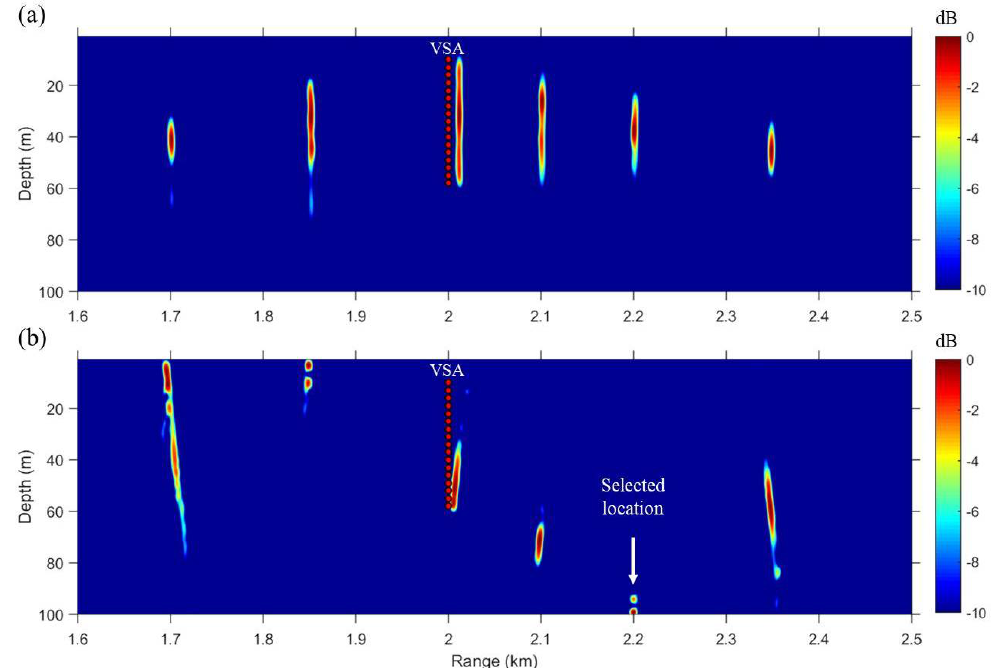
Figure 1. (Color online) Schematic of virtual source array (VSA)-based time reversal (TR) focusing and waveguide conditions used for numerical simulations. ( a ) Different vertical arrays, denoted by time-reversal mirror (TRM) (blue circle) and VSA (red circle), of 27 and 17 elements with 3-m array spacing are considered in 100-m deep shallow water; ( b ) Sound speed profile used for normal mode simulations.